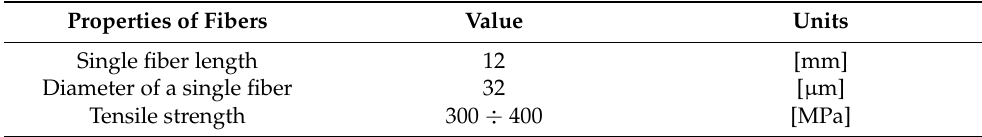
Table 3. Properties of polypropylene